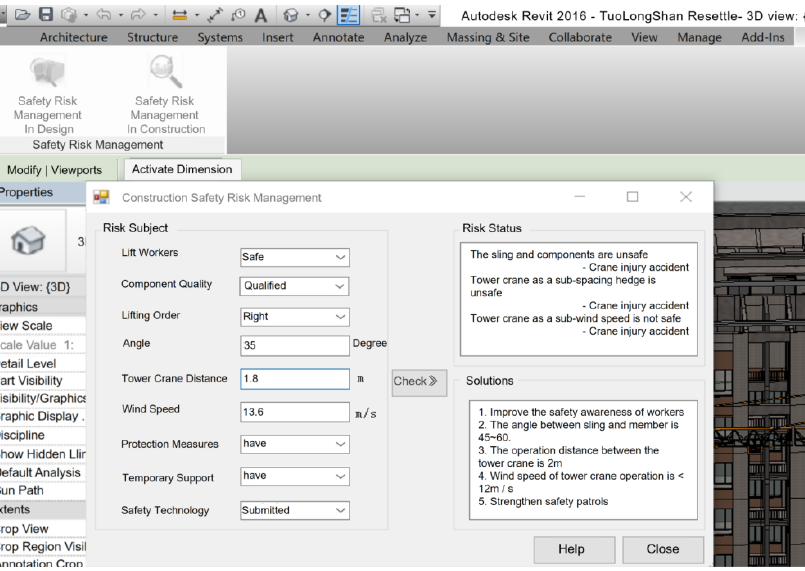
Figure 16. Operation results of the “ construction safety risk management ” function.